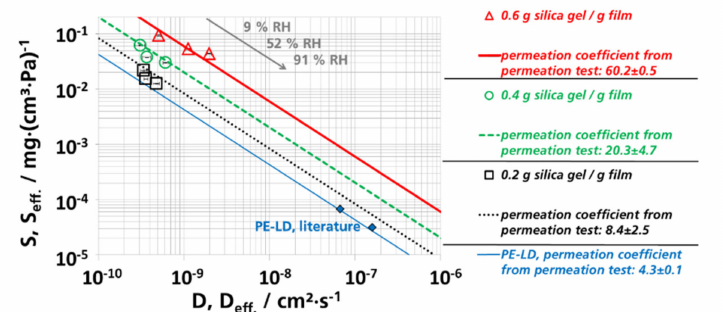
Figure 10. Pairs of values for the e ff ective di ff usion ( D ef f . ) and e ff ective sorption coe ffi cients ( S ef f . ), determined by sorption experiments; transverse lines represent permeation coe ffi cients ( P ef f . ), determined by permeation measurements with the unit (mg · cm · (cm 2 · s · Pa) − 1 ) · 10 12